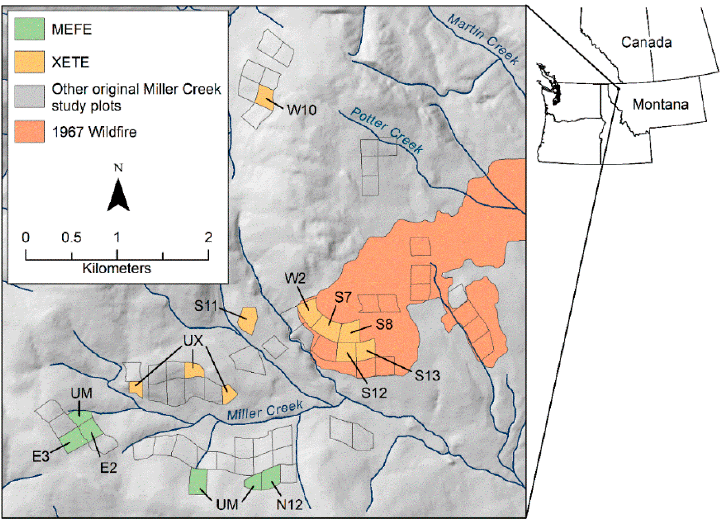
Figure 1. During 1967, a study was established in northwestern Montana, in the northwestern portion of the USA, with 15 original 4.05-ha plots on each of four cardinal aspects (60 plots total), with the intention to examine the e ff ects of combinations of harvesting and prescribed fire on conifer regeneration, particularly L. occidentalis . The 1967 wildfire burned or re-burned some of the original plots. In 1996, we selected proximate stands of undisturbed forest in the Menziesia ferruginea (MEFE) and Xerophyllum tenax (XETE) phases within the Abies lasiocarpa / Clintonia uniflora habitat type and relocated 9 of the original study plots with various combinations of habitat type phase, anthropogenic activity (undisturbed or harvested stands with or without prescribed fire), and a stochastic event (wildfire) to obtain 11 distinct disturbance categories. See Table 1 for plot identifications and descriptions. Adapted from [46] (p. 6) and [51] (p. 6).